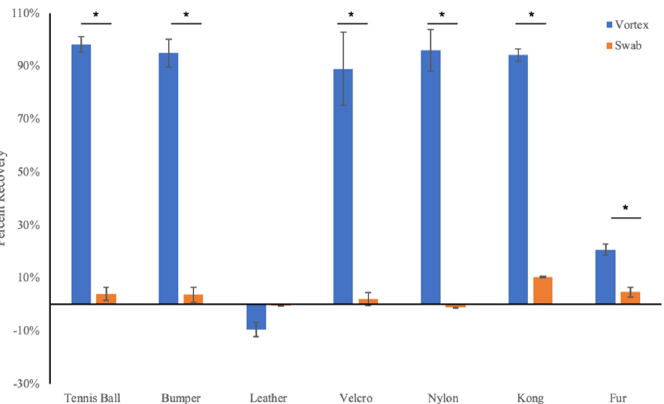
Figure 2. Vortexing using growth medium is more efficient than wet swabbing for recovery of trypan blue dye dried on various surfaces. Values are expressed relative to the absorbance of growth medium spiked directly with trypan blue. N = 3; * p < 0.05.